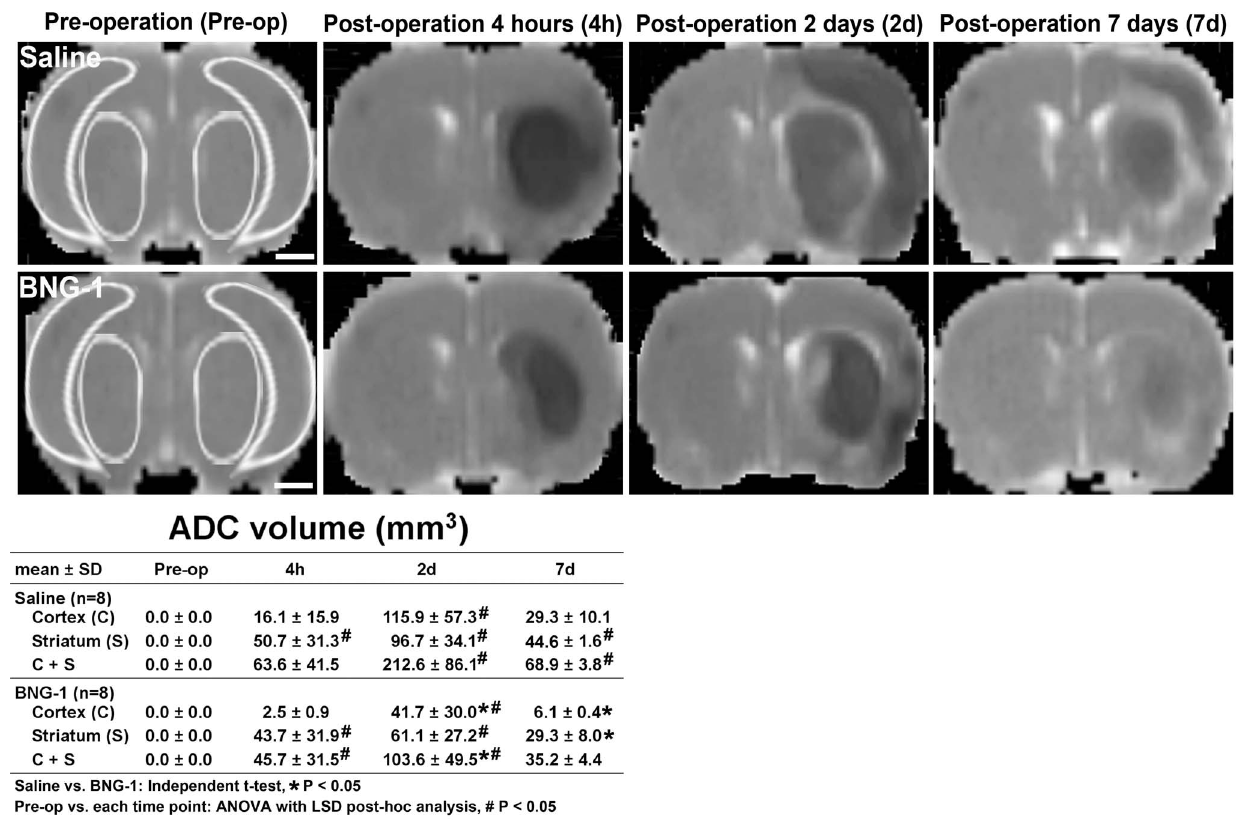
Fig. 2. Comparison of the temporal changes in the ADCs after focal cerebral ischemia between the saline and BNG-1 treatments. The ADC indicates that the lesion volume (dark region) is smaller in the BNG-1 group than the saline group at 2 d and 7 d on the lesion cortex and at 7 d on the lesion striatum. The bar in the pre-operation panels indicates 2.5 mm. The template for region of interest is demonstrated in the brain map of pre-operation rat, which is used for quantitative measurement of ADC, CBF and MIP.